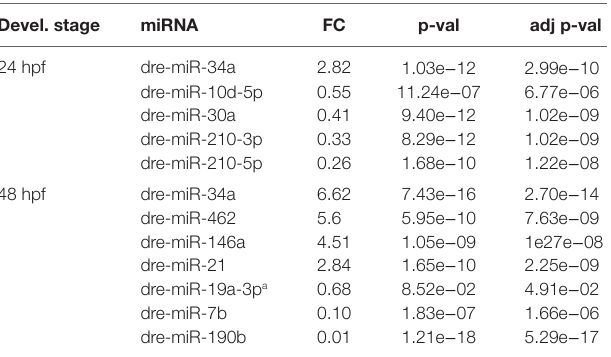
Table 1 | selected differentially expressed mirnas at 24 and 48 hpf. Devel.